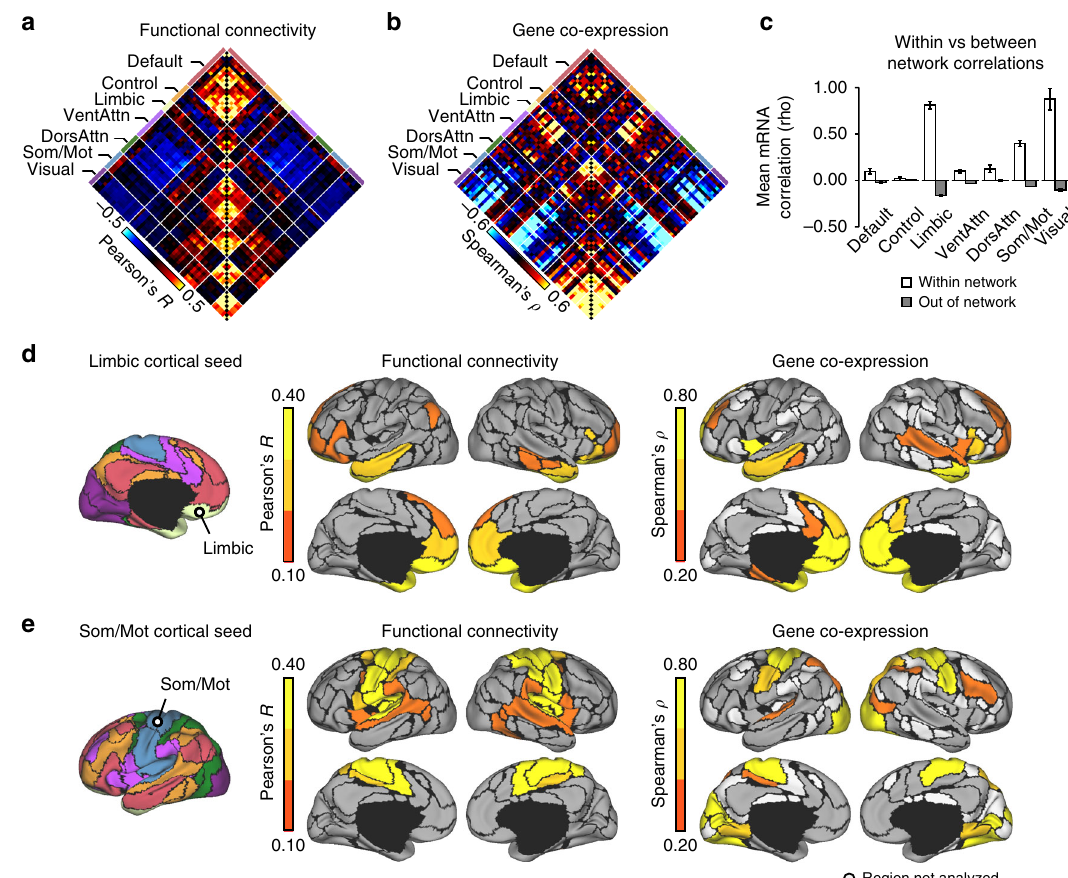
Fig. 2 Anterior and posterior genetic gradients in the cortex. a Correlation matrix shows fcMRI based coupling for 59 cortical regions ( N = 1000) from the 17-network parcellation of Yeo et al. 36 , corresponding to cortical areas containing tissue samples from both bi-hemispheric AHBA donors. Regions are arranged such that those belonging to the same functional network are grouped together. Functional network correlations reveal both positive (red) and negative (blue) associations. b Correlation matrix shows the coupling of gene expression across the cerebral cortex, averaged across the two bi- hemispheric AHBA donors. A total of 2664 genes were examined, de fi ned based on differential expression across cortical networks in independent data from 4 left-hemisphere AHBA donors ( q ≤ 0.01). c Bar graphs display the gene expression similarity (region-to-region correlation) for parcels within, and out of, the corresponding network territories. Data points re fl ect the average within and between network correlation values for each bihemispheric donor. Error bars re fl ect ± 1 SEM. d The average functional and genetic correlation pro fi les of bilateral limbic OFC seed regions and e bilateral dorsal somato/ motor seed regions, displayed across medial and lateral surface representations of the 17-network cortical parcels from Yeo et al. 36 . DorsAttn, dorsal attention; Som/Mot, somato/motor; VentAttn, ventral attention and ( F 1,5 = 0.96, p = 0.37), and ventral attention networks ( F 1,5 = 27.98, p ≤ 0.005; greater between- than within-network expres- sion). The signi fi cant negative relationship observed in ventral